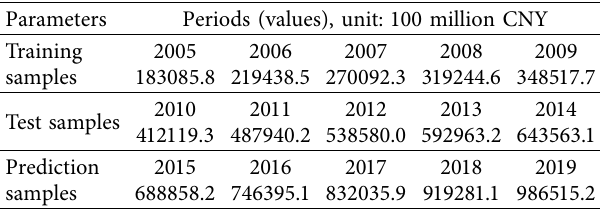
Figure 8: Simulation and prediction process based on BP network. Table 2: The economic system parameters selected.